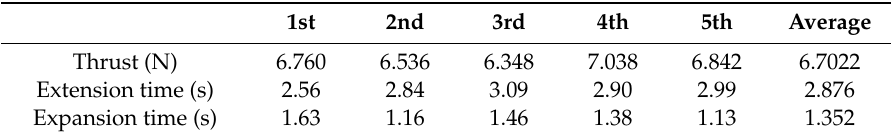
Table 5. Test results of designed prototype